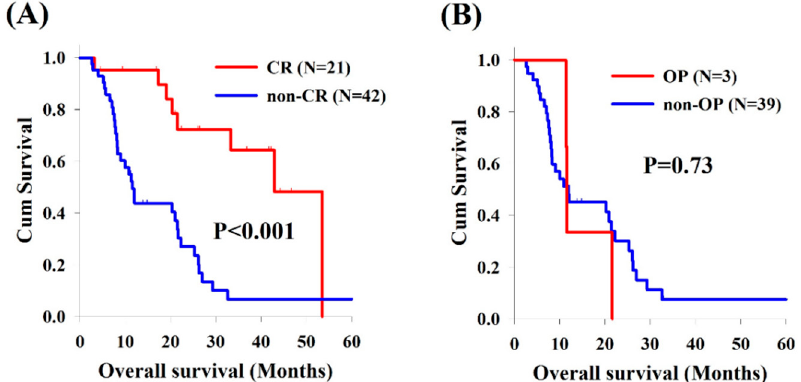
Figure 3. Kaplan–Meier survival curves of overall survival among patients with cervical esophageal squamous cell carcinoma: ( A ) CR group versus non-CR group; and ( B ) OP versus non-OP in the non-CR group. CR, complete response; OP, operation.